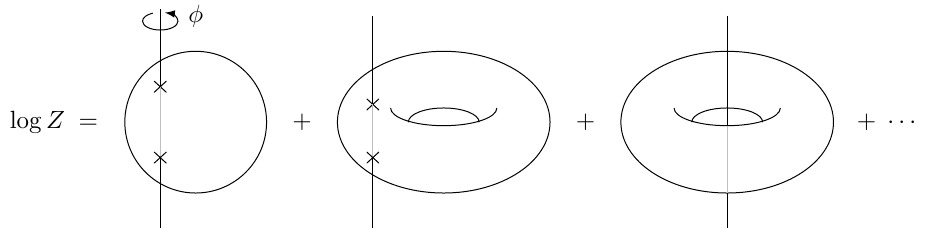
Figure 2 . In string theory, log Z ( (cid:12) ) is a sum of connected string diagrams embedded in a Euclidean spacetime with a conical defect of angle (cid:12) at the entangling surface. Only closed string diagrams that intersect or encircle the entangling surface, such as those depicted above, contribute to the entanglement